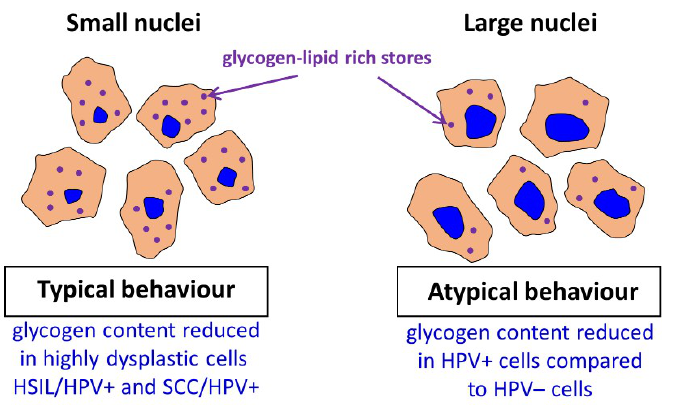
Figure 4. Summary of obtained key results.